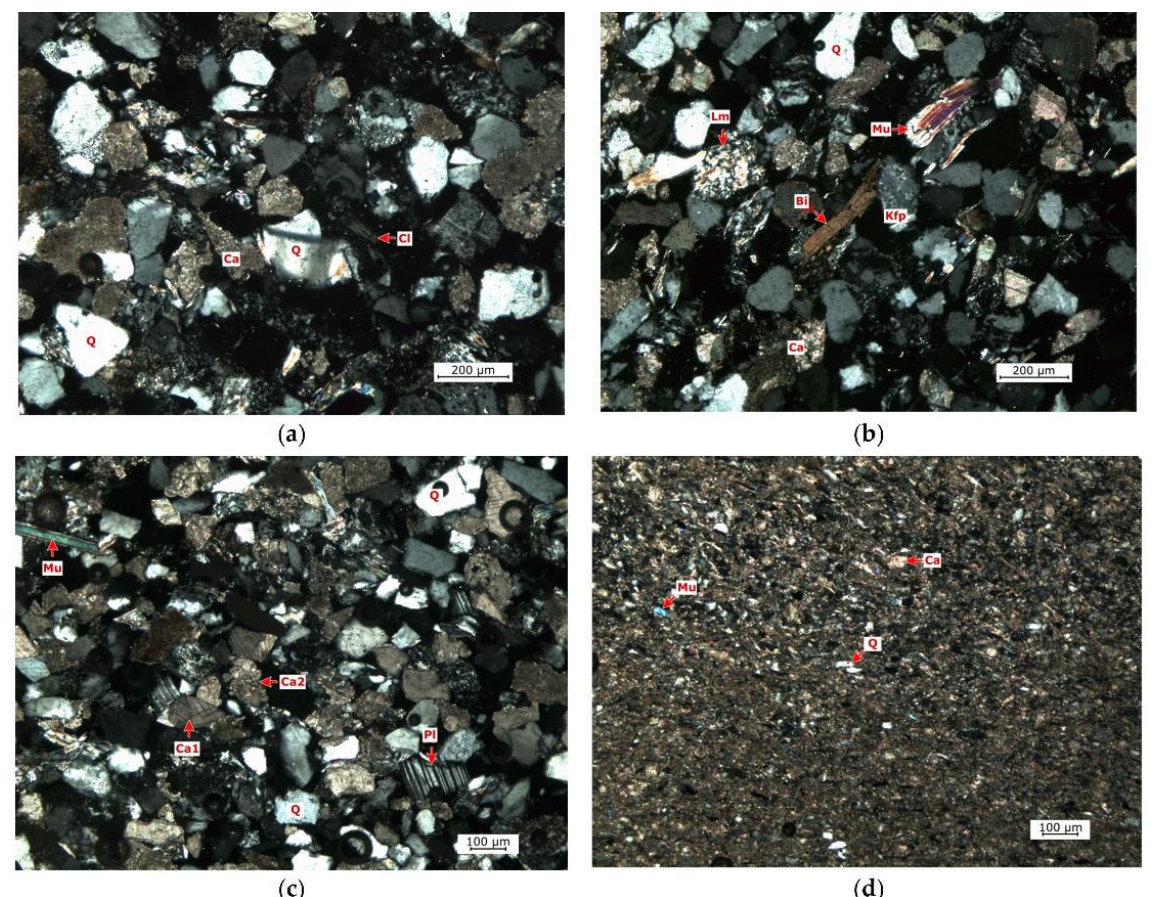
Figure 9. Photomicrographs of samples X. ( a ): chlorite grain in sandstone, ( b ): biotite, muscovite, and K-feldspar crystals in sandstone and metamorphic rock fragments, ( c ): fragmented micrite, fiber sparite, and plagioclase crystals in very fine-grained sandstone, ( d ): aleurite layer boundaries. The dark grey argillaceous marl and siltstone appear as massive units and as alter- nations of marl and siltstone laminae. In fine grained marls and siltstones, the amount of mica is significant. The darkish colour is the result of an increased amount of coaly plant fragments and clay